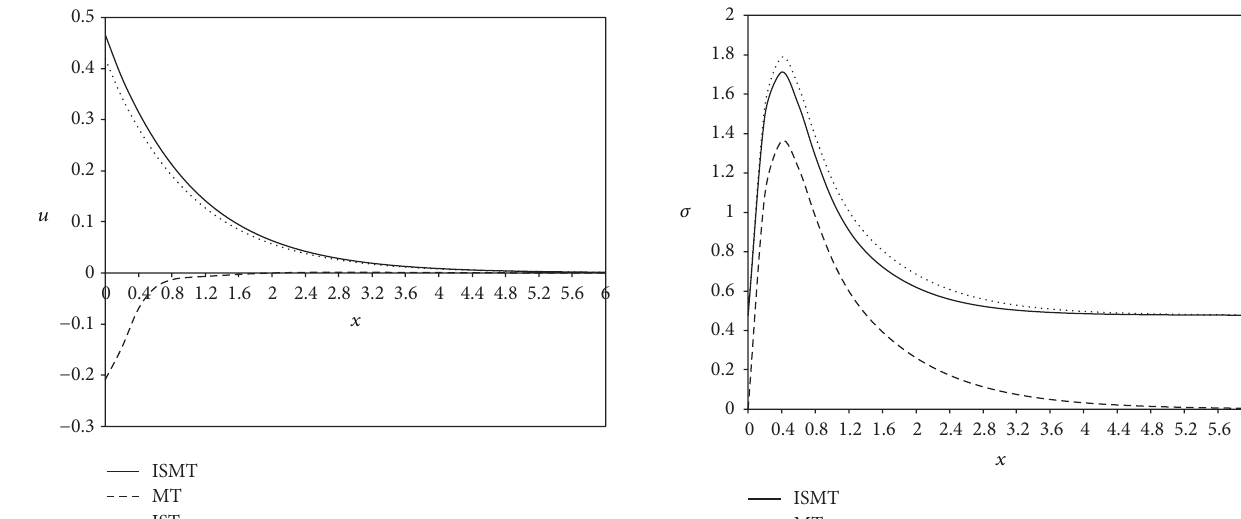
adverse when 0.8 ≤ 𝑥 ≤ 6 . The difference is significant in the range 0 ≤ 𝑥 ≤ 2.8 .